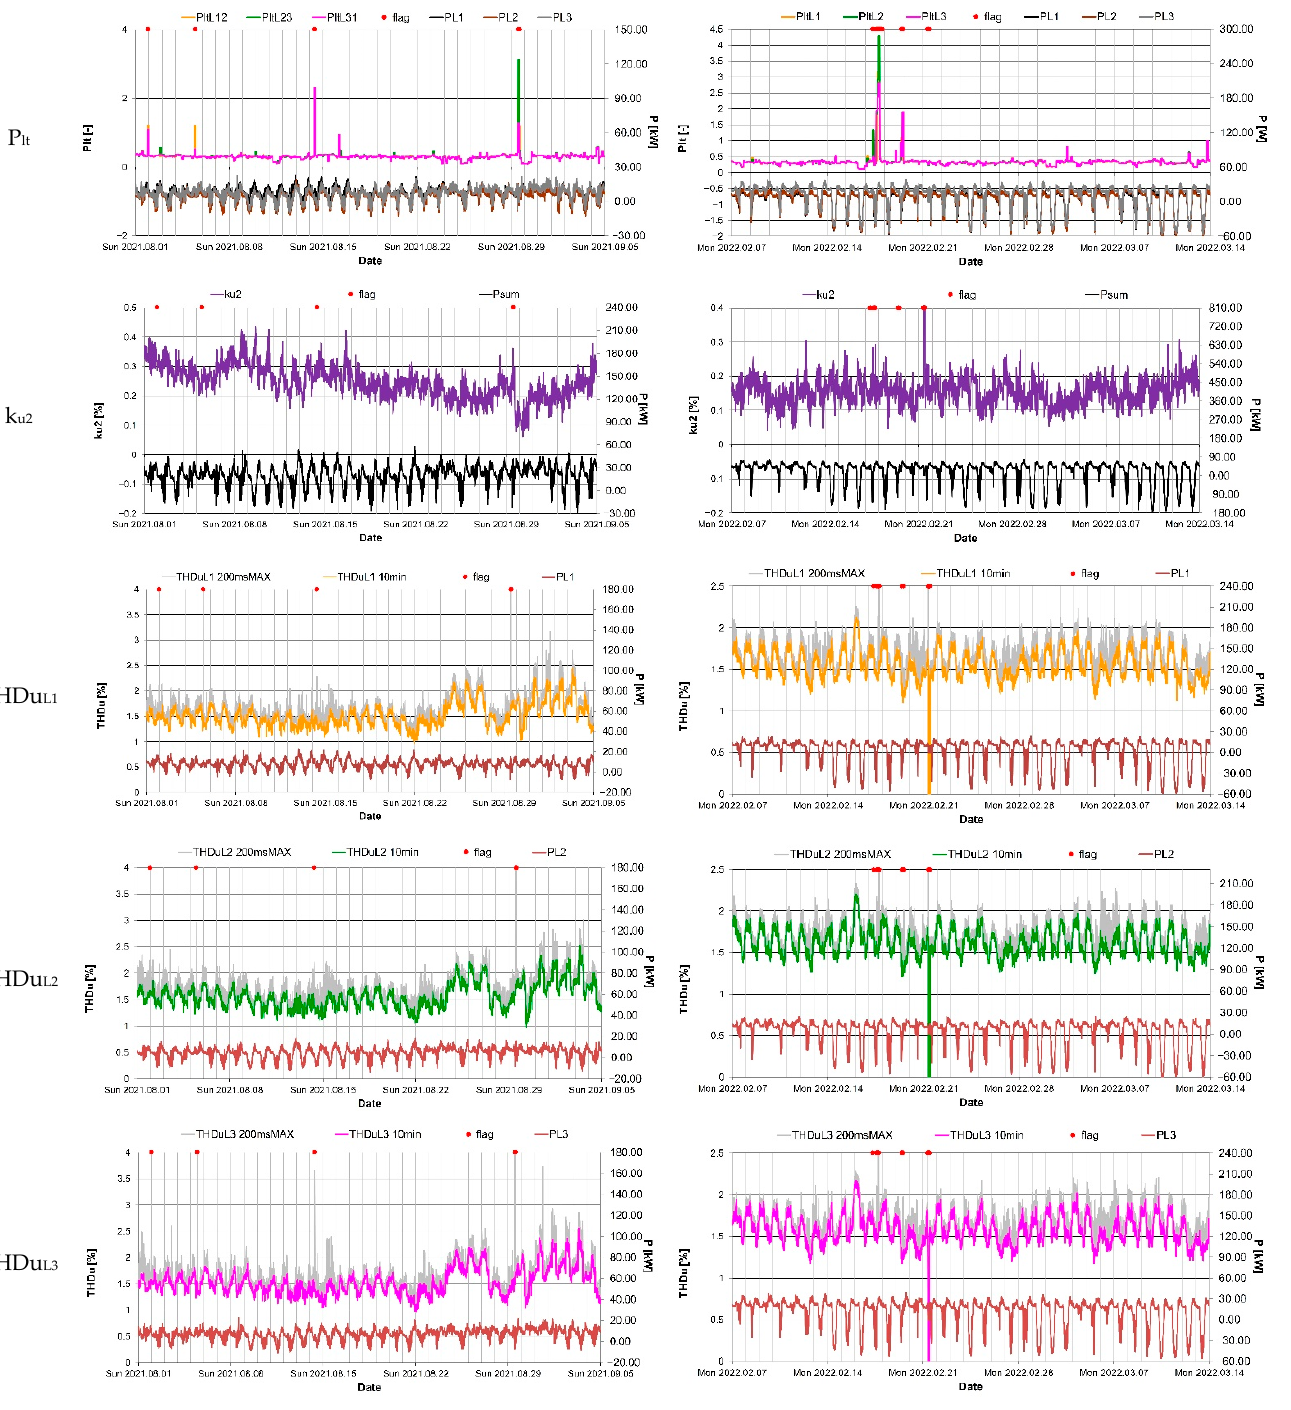
Figure 5. The course of the variability of the parameter in the tested measuring point for Period 1 (before the microgrid implementation) and Period 2 (after the microgrid implementation).